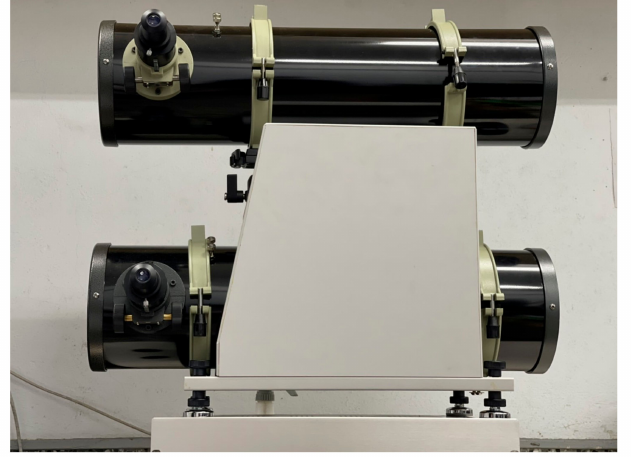
Figure 9. Double Newtonian telescope system: The primary and secondary mirrors of the upper telescope settled by Ag-enhanced mirrors and those of the lower fixed by Al-coated